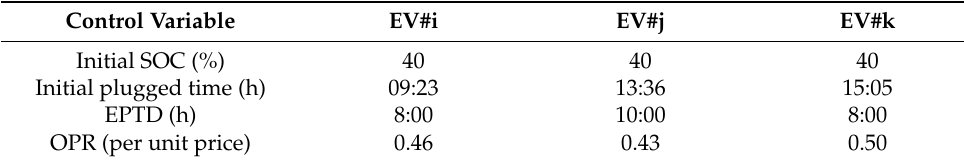
Table 2. Initial parameter and owner preferences for arbitrary EVS.